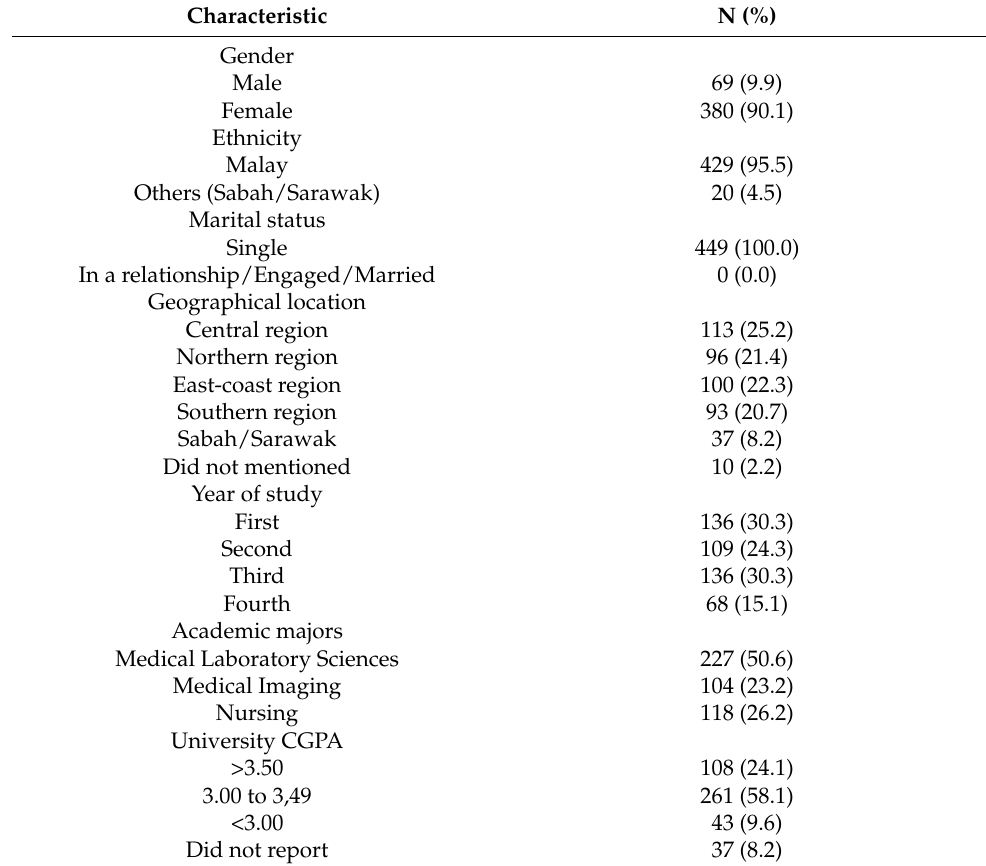
Table 2. Demographic characteristics of the studied participants (N =